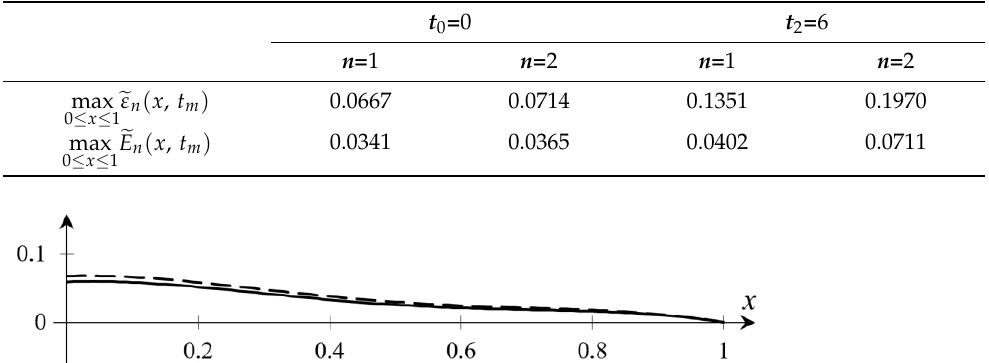
Figure 8. Graphs of the functions 𝜀 1 (𝑥, 0) (solid line) and 𝜀 2 (𝑥, 0) (dashed line). The graphical representation of the functions 𝜀 𝑛 (𝑥, 3) , 𝑛 = 1,2 , is shown in Figure 9.